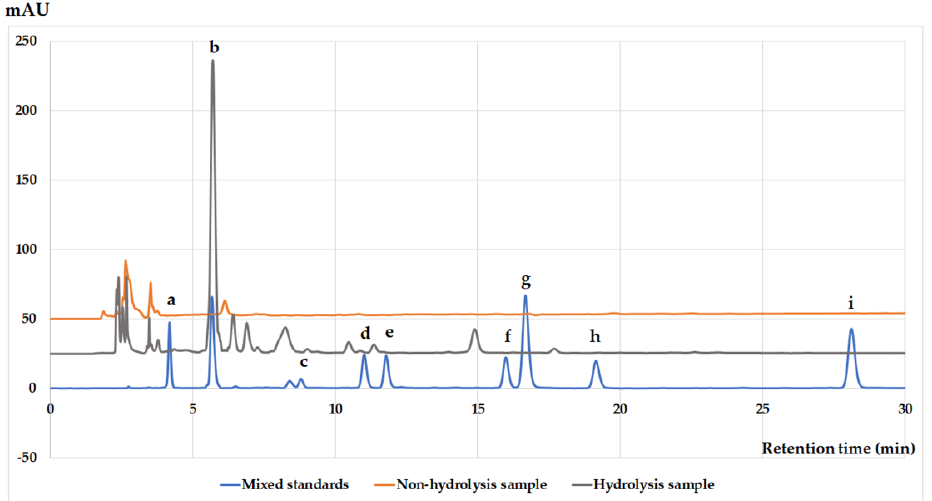
Figure 2. HPLC chromatographic separation (using UV detection at 278 nm) of seven catechins including gallic acid and caffeine in a standard mixture (blue line) compared to the non − acid hydrolyzed PRRE (orange line) and acid hydrolyzed PRRE (gray line). Note Gallic acid (a), Gallocatechin (b), Epi- gallocatechin (c), Catechin (d), Caffeine (e), Epicatechin (f), Epicallocatechin gallate (g), Gallocatechin gallate (h), Epicatechin gallate